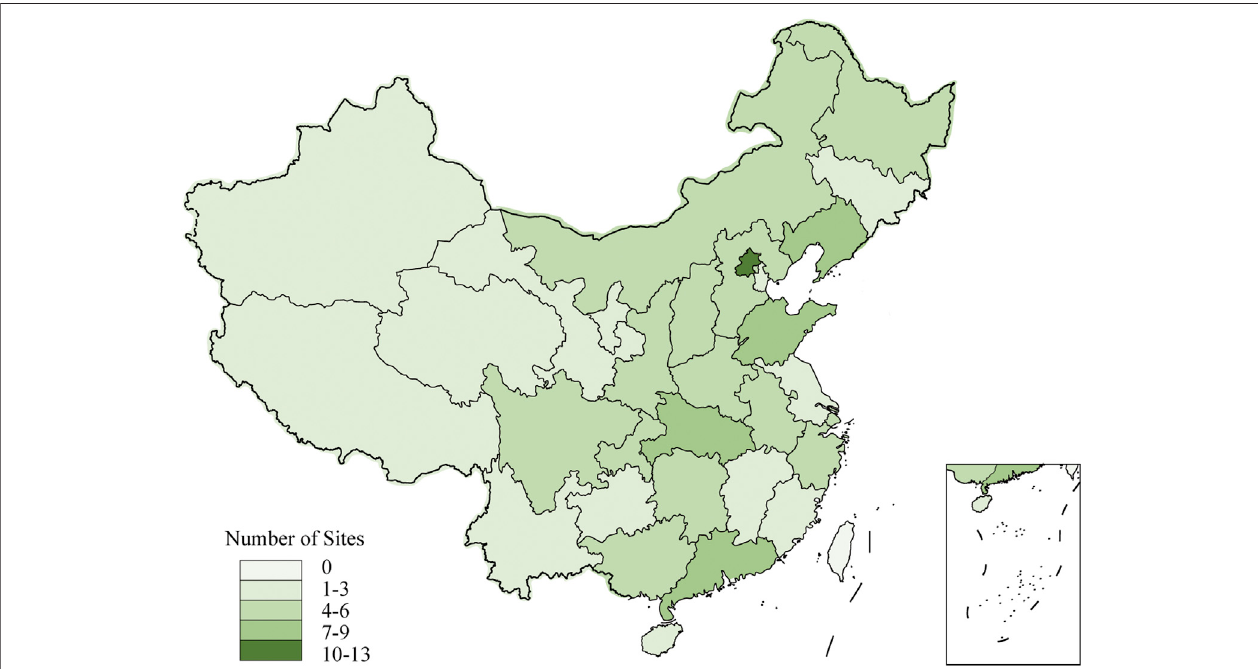
FIGURE 2 | Sites distribution of CASES-TCM